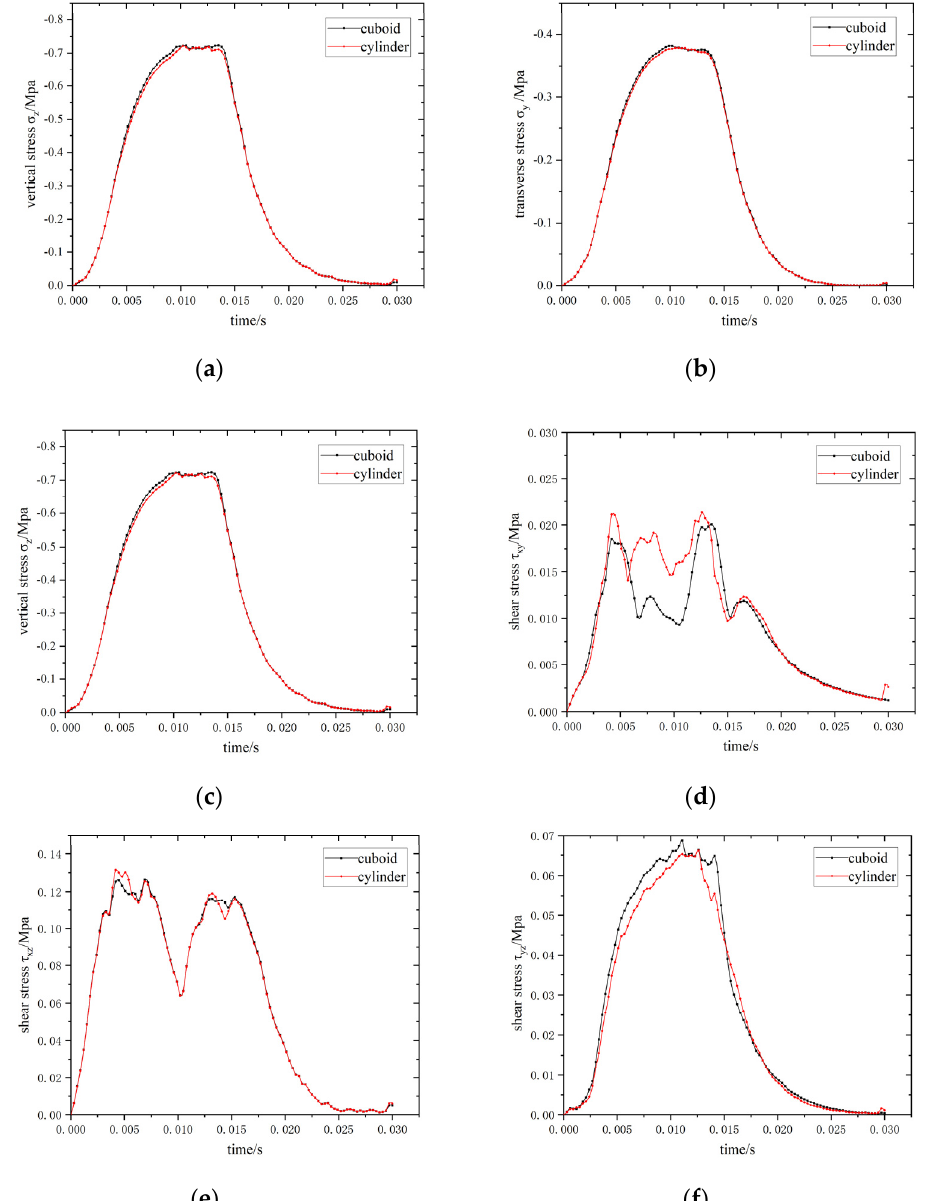
Figure 11. Maximum stress–time curves of elements at the interface. ( a ) Longitudinal stress ( σ x ); ( b ) transverse stress ( σ y ); ( c ) vertical stress ( σ z ); ( d ) shear stress ( τ xy ); ( e ) shear stress ( τ xz ); ( f ) shear stress ( τ yz ).